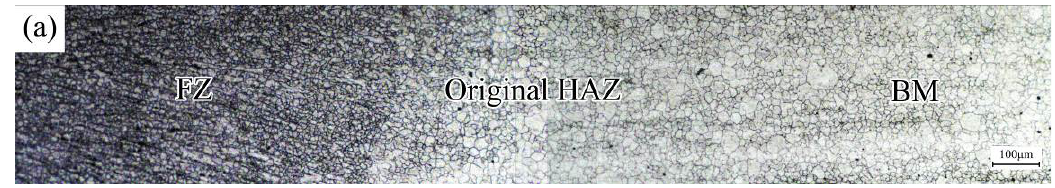
Figure 7. Metallographic structure of ( a ) FZ; ( c ) CGZ; ( e ) FGZ; ( g ) IRZ and grain morphology of ( b ) FZ; ( d ) CGZ; ( f ) FGZ; ( h ) IRZ of weld joint welded under 30